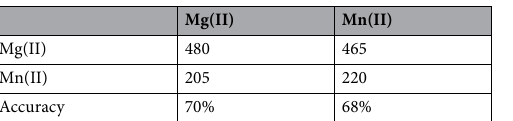
Table 1. Confusion matrix for the LDA classifier using Leave-One-Out (LOO) cross-validation on the 1370 atoms. The columns represent the true classification and the rows are the LDA predictions. The accuracy [70% for Mg(II) and 68% for Mn(II)] should be compared against the baseline of a random guess, the accuracy of which is